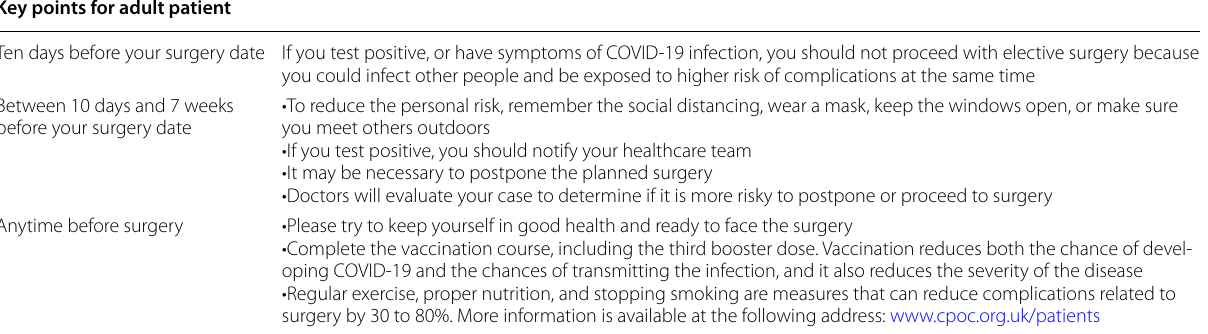
(E-Table 3 in the Additional file 1: Steps in the risk assessment process of adult patient)